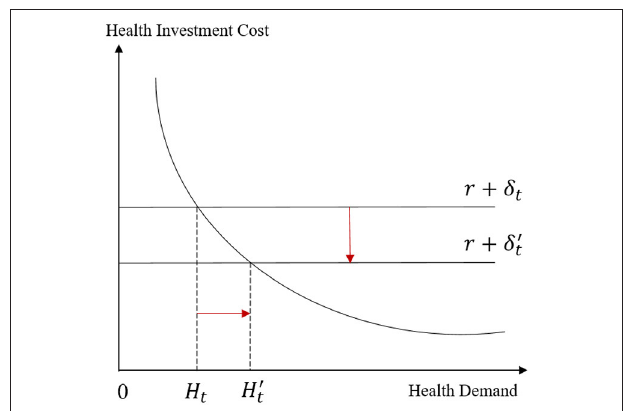
FIGURE 2 | Balanced analysis of health